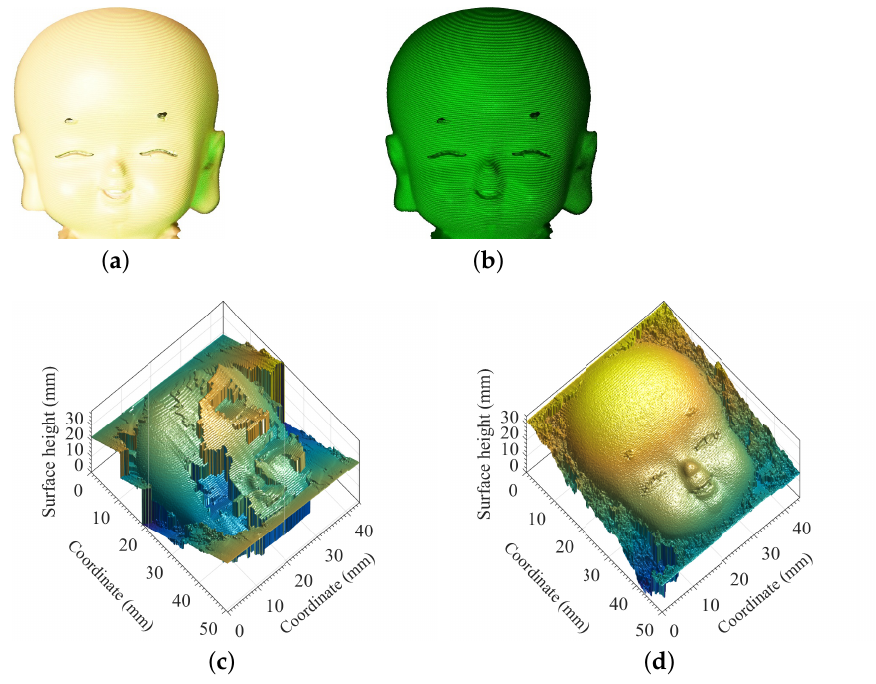
Figure 9. Human-head-model retrieval as background illuminance E = 500 Lux for indoor measure- ment. ( a ) without filtering; ( b ) with filtering; ( c ) retrieval using the image of ( a ); ( d ) retrieval using the image of ( b